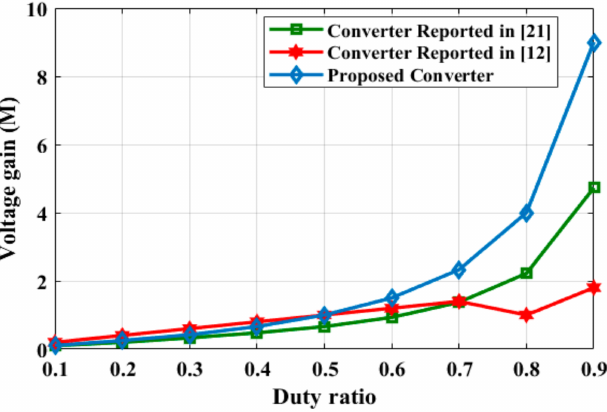
Figure 5. Voltage gain comparison of the proposed converter and similar converters. Table 1. An overview of the proposed converter’s performance compared to existing